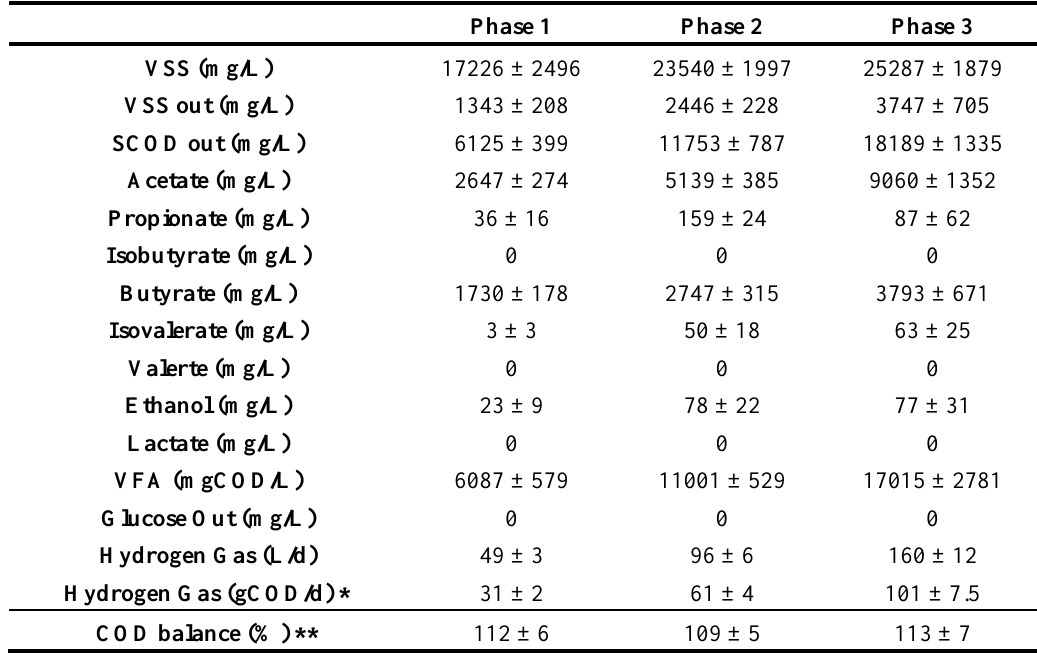
Table 3. Metabolites and COD mass